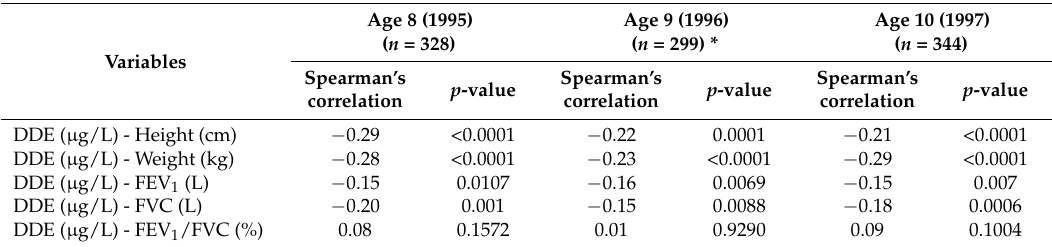
Table 2. Spearman’s correlations for dichlorodiphenyl dichloroethene (DDE) with anthropometric and pulmonary function measures in years 1995, 1996, and 1997.